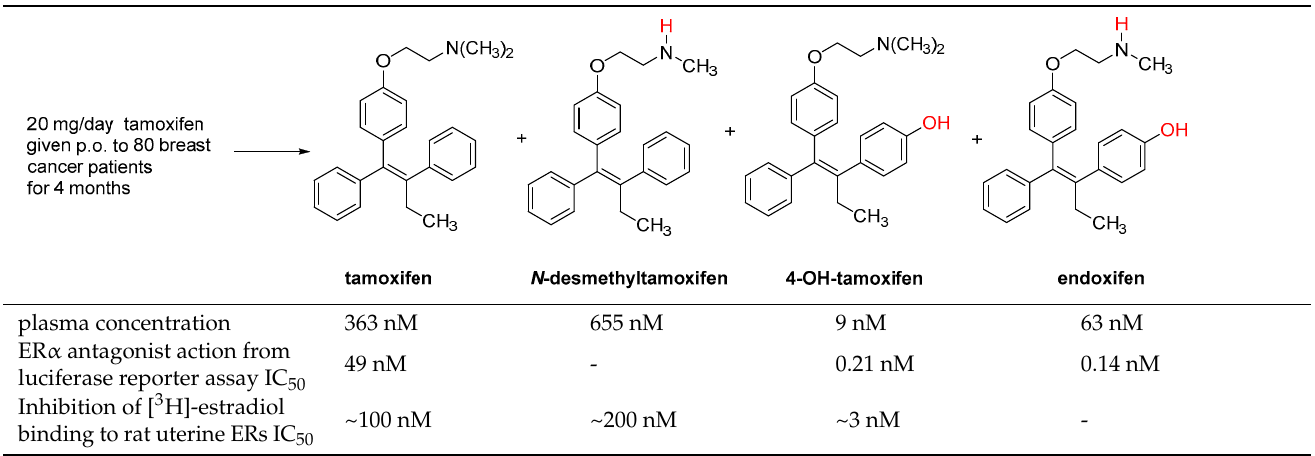
Table 2. Structures of major metabolites of tamoxifen, their plasma concentrations in women taking tamoxifen [36], their antagonist activities at ER α [29] and binding affinities to rat uterine ERs